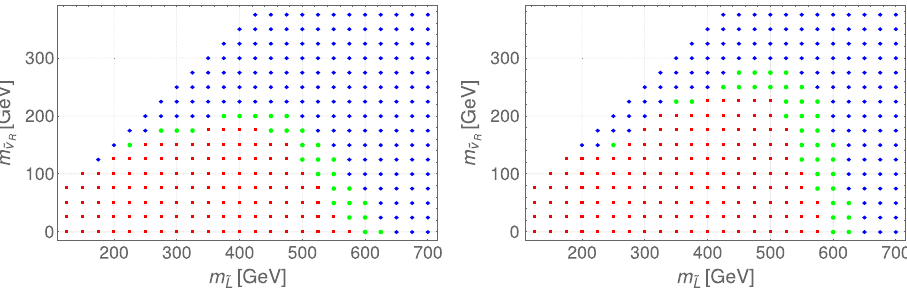
Fig. 7 Constraints on combinations of m ˜ ν ( M 1 = M 2 = 1 PeV) on the left (right) panel. We fix μ = m ˜ ν